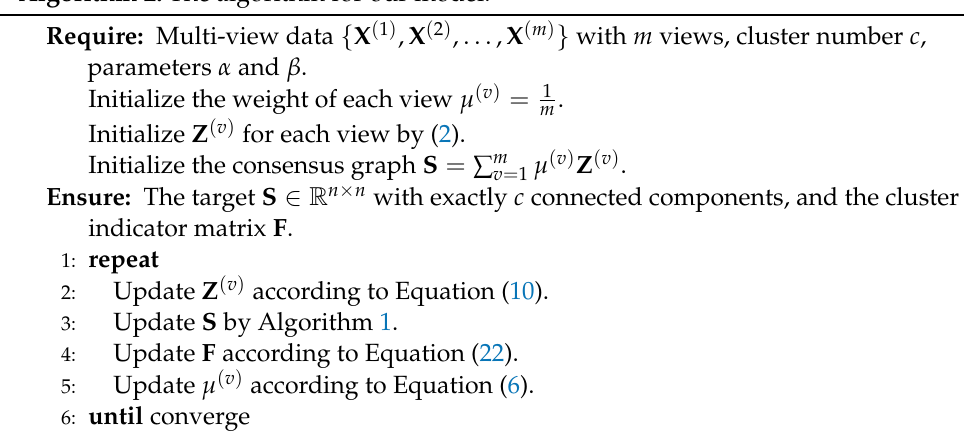
Algorithm 2: The algorithm for our model.